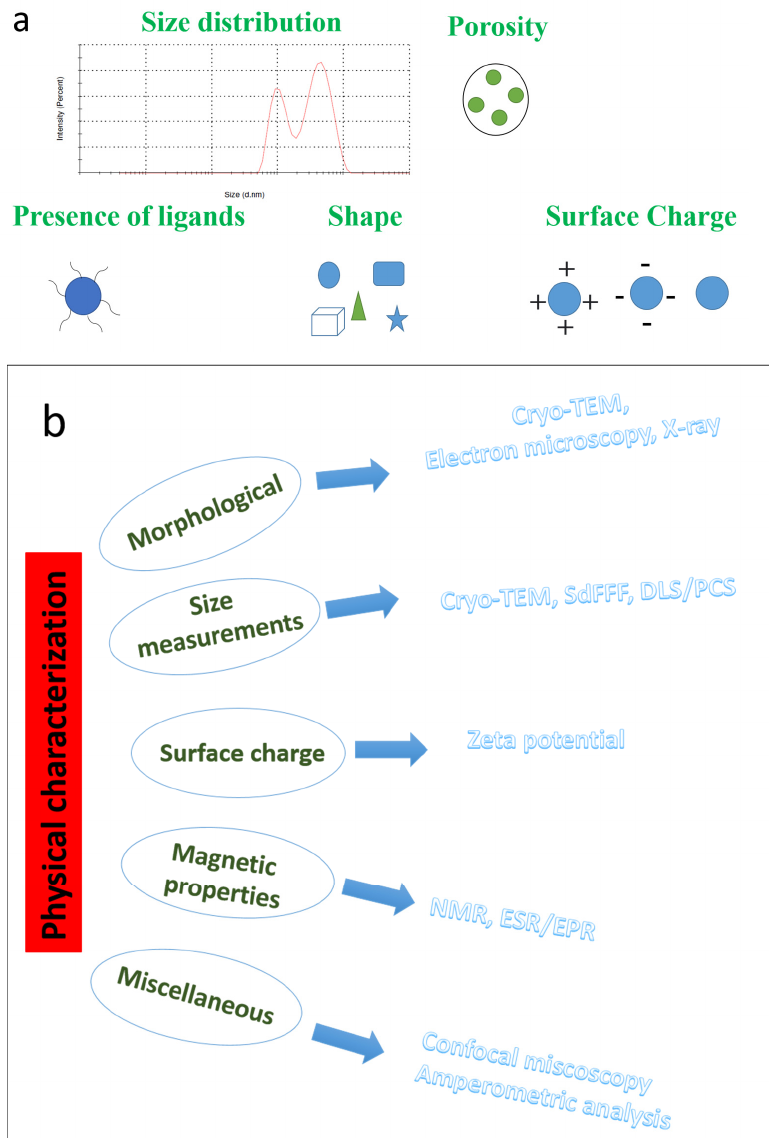
Figure 2. Schematic resume of the principal parameters ( a ) and techniques ( b ) used for nanoparticles characterization.